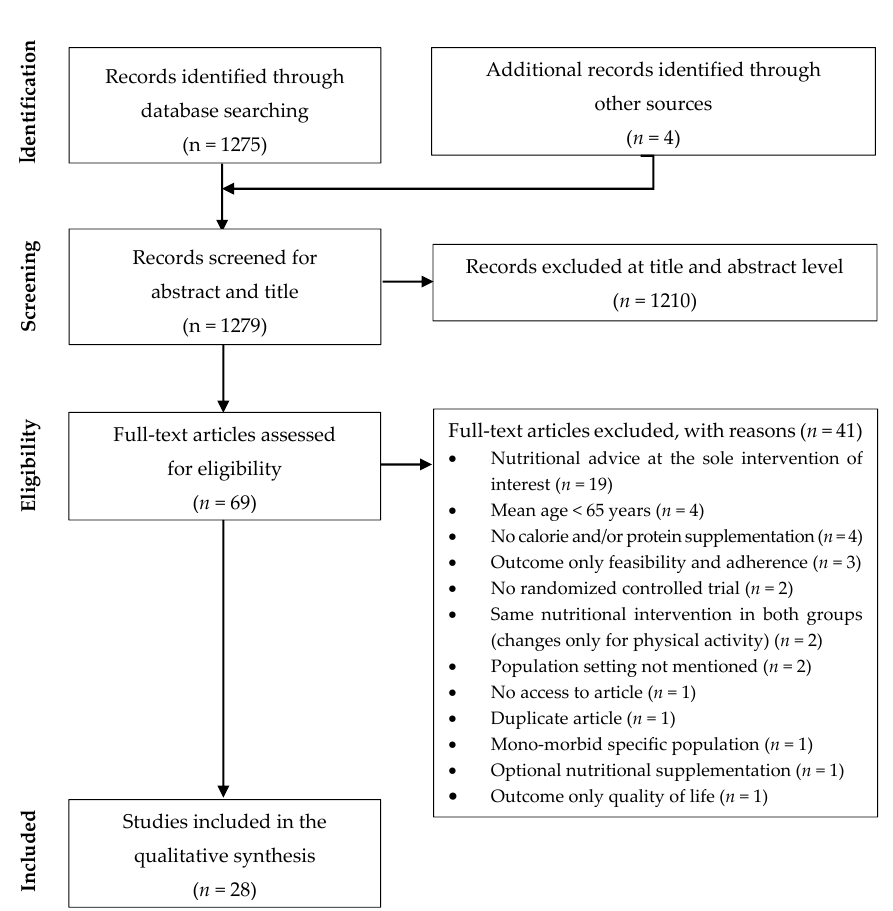
Figure 1. Flow diagram of studies in selection